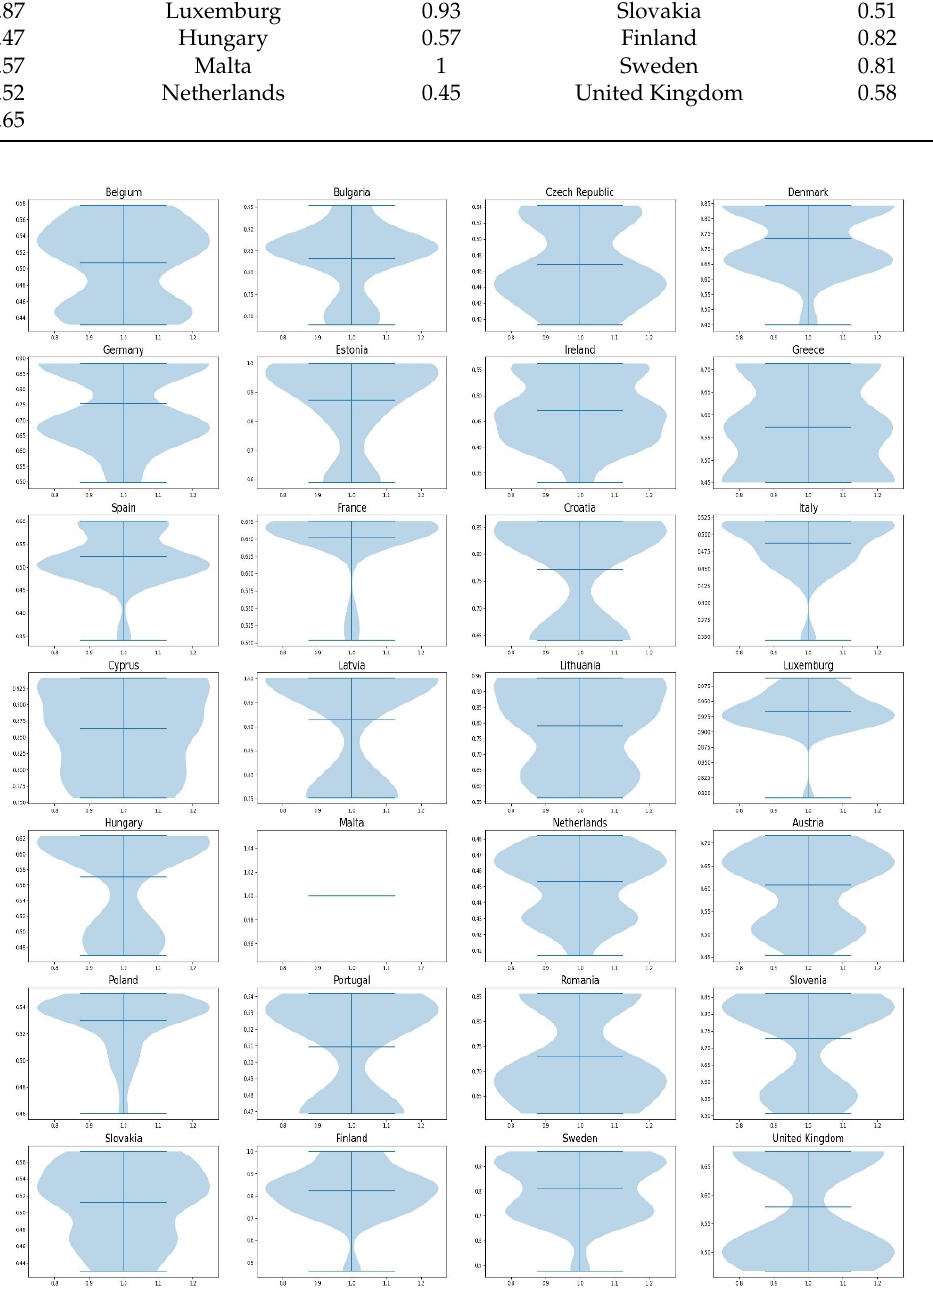
Figure 4. Violin plots of the sustainability of 135 different perceptions calculated with the proposed, alternative metric two-stage DEA. The y axis indicates the measurement of sustainability, while the x axis indicates the distribution of the sustainability indices that were calculated; wider sections of the density indicate that there is a higher probability that data points will take the given value, while narrow sections indicate lower probability. The first aspect to observe is that Latvia concentrates the majority of their values on the upper side of the violin plot, while Malta has a constant value of one for all calcula- tions, indicating that compared to the rest, the two countries have a high sustainability no matter the perception; thus, the robustness of the conclusion increases. For the rest of the countries, the different perceptions create different situations for their sustainability. For example, Greece has a mean sustainability of 0.57; however, its values can change depend- ing to the perception from 0.45 to 0.75, with the majority of the values concentrated be- tween 0.5 and 0.6. Thus, the sustainability of Greece changes with different perceptions in a significant way, weakening the declaration of any robust conclusions.